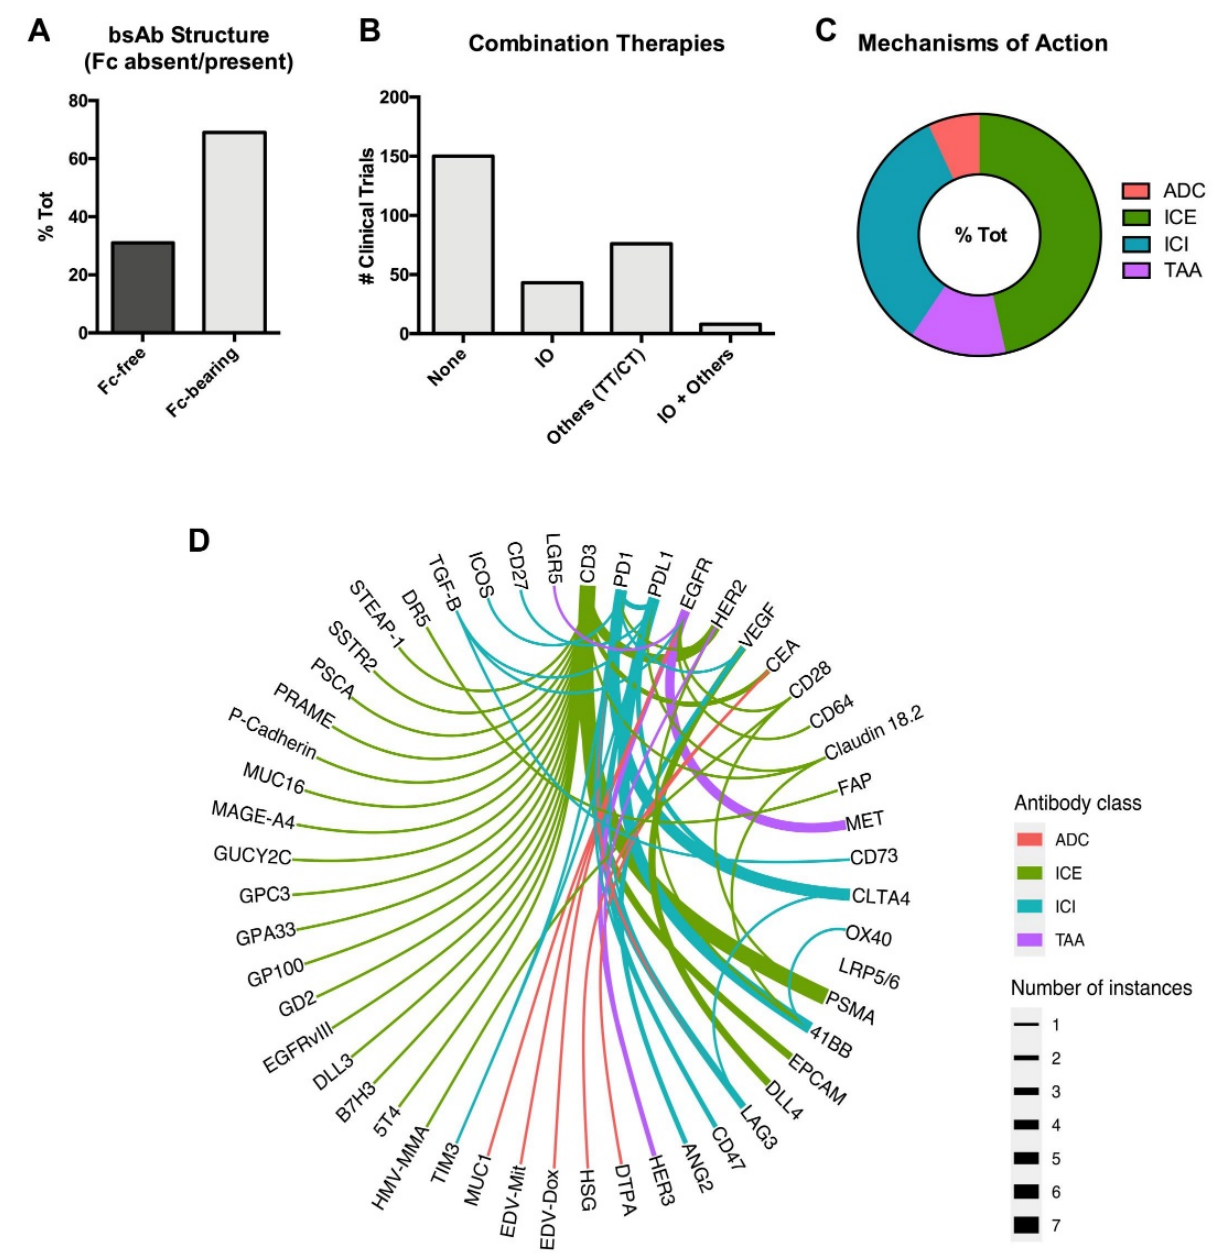
Figure 2. Outline of bsAb-based Clinical Trials in Solid Malignancies. ( A ) Bar graphs showing the percentage of clinical trials utilizing either Fc-free or Fc-containing bsAbs out of total number of bsAbs. Fc, Fragment, crystallizable. ( B ) Bar graphs showing the number of clinical trials utilizing bsAbs either alone or in combination with immunotherapies (IO), other agents (target therapies, TT; chemotherapies, CT), or both. ( C ) Pie chart showing the percentage of clinical trials utilizing bsAbs in solid tumors based on their mechanisms of action out of total number of bsAbs. Antibody Drug Conjugate, ADC; Immune Cell Engager, ICE; Immune Checkpoint Inhibitor, ICI; Tumor-Associated Antigen-targeting, TAA. ( D ) Chord diagram showing interactions amongst bsAbs utilized in clinical trials against solid tumors (each instance is a different